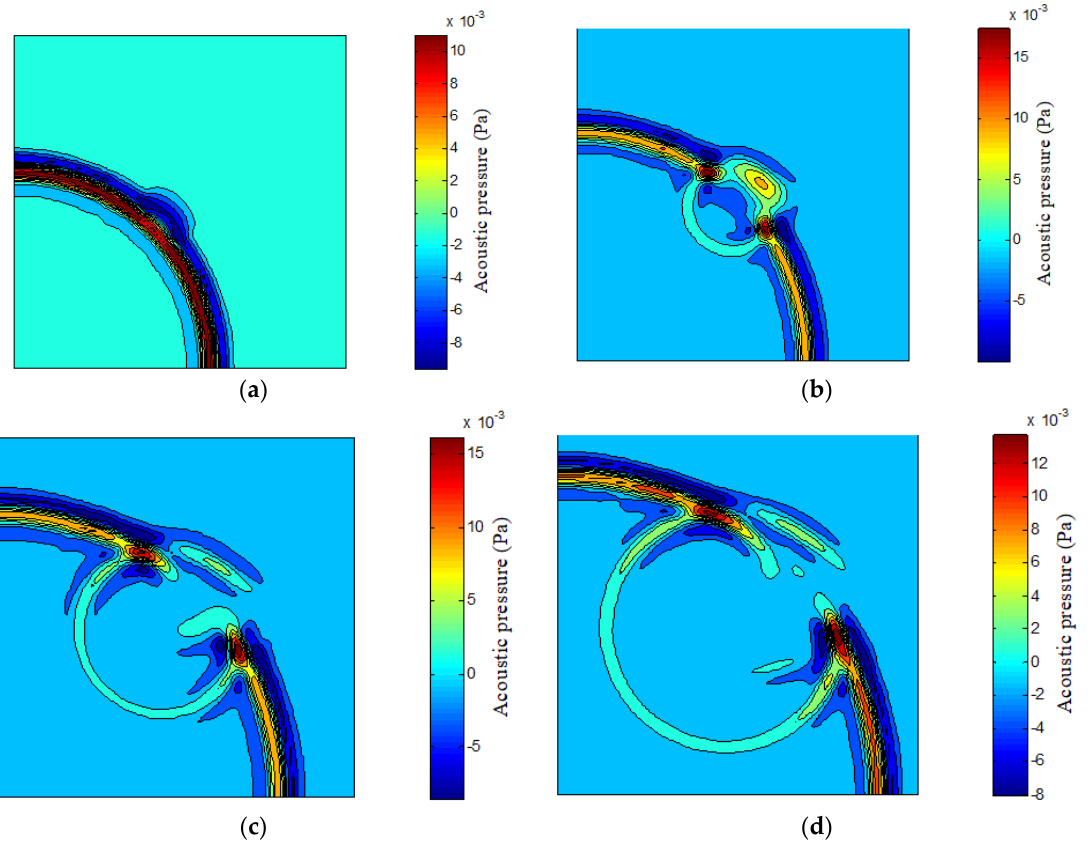
Figure 21. The computed RPIM ( α s = 3 h )results of the acoustic wave scattering by irregular object in the whole problem domain for several observation time points: ( a ) t = 0.7 s; ( b ) t = 0.8 s; ( c ) t = 0.9 s; ( d ) t = 1 s.